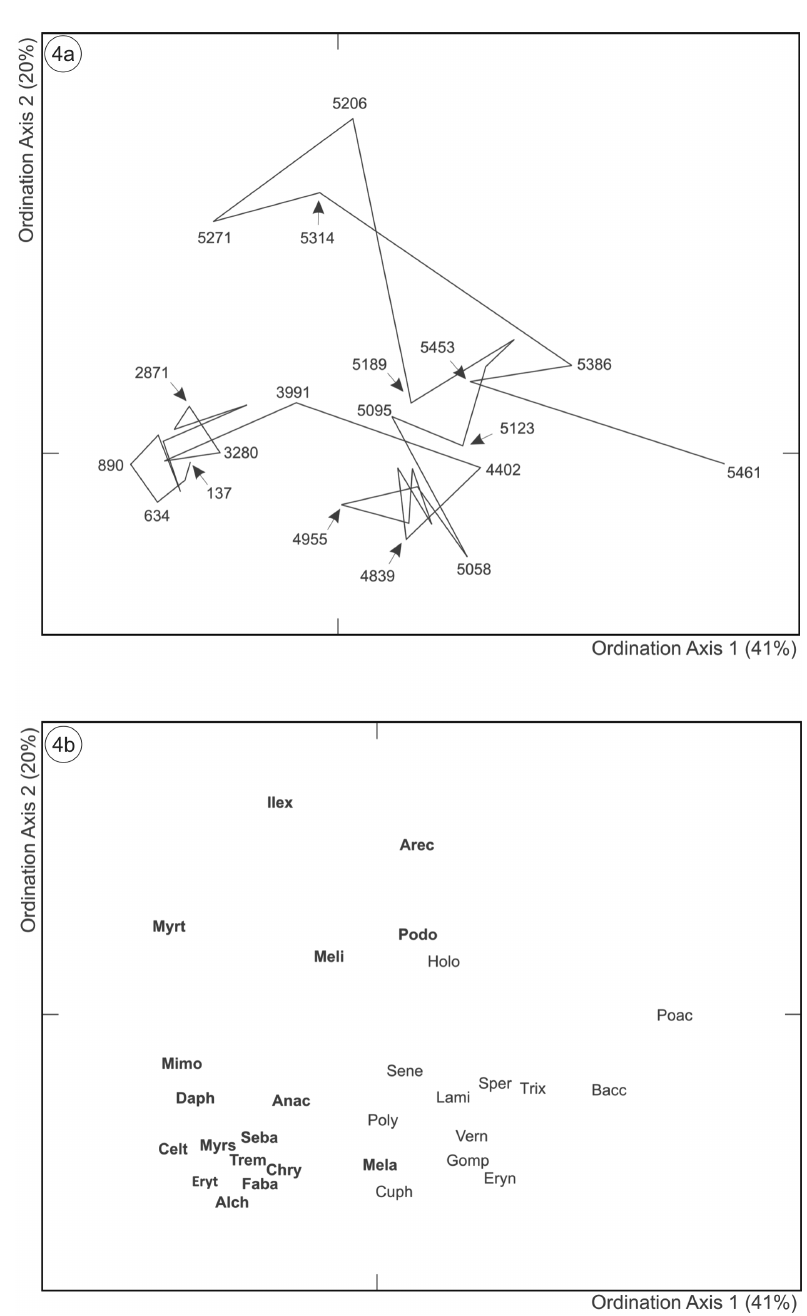
Fig. 4 – The diagram map of the vegetation trajectory for the last 5461 cal yr BP in (a) and (b) . Calibrated years BP (i.e. before AD 1950) are indicated for some points. Arboreal (in bold) and herb taxa are shown in positions that are proportional to their correlation level with the ordination axis (only taxa with the highest correlations are indicated); the corresponding overlapped diagrams would form biplots. The tick marks on the axes indicate the origin coordinates. Taxa abbreviations: Alch = Alchornea , Anac = Anacardiaceae, Arec = Arecaceae, Bacc = Baccharis -type, Celt = Celtis , Chry = Chrysophyllum , Cuph = Cuphea , Daph = Daphnopsis racemosa , Eryn = Eryngium , Eryt = Erythrina -type, Faba = Fabaceae, Gomp = Gomphrena , Holo = Holocheilus -type, Ilex = Ilex , Lami = Lamiaceae, Mela = Melastomataceae, Meli = Meliaceae, Mimo = Mimosa serie Lepidotae , Myrs = Myrsine , Myrt = Myrtaceae, Poac = Poaceae, Podo = Podocarpus , Poly = Polygala , Seba = Sebastiania , Sene = Senecio -type, Sper = Spermacoce , Trem = Trema micrantha , Trix = Trixis -type, Vern = Vernonia